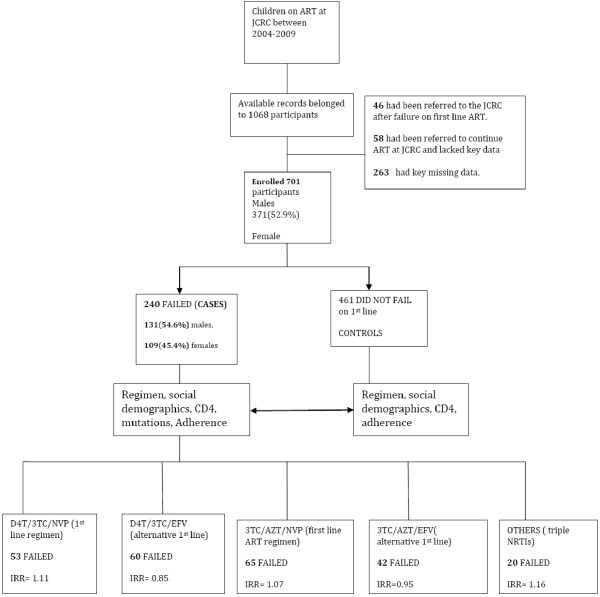
Study profile of the study participants.